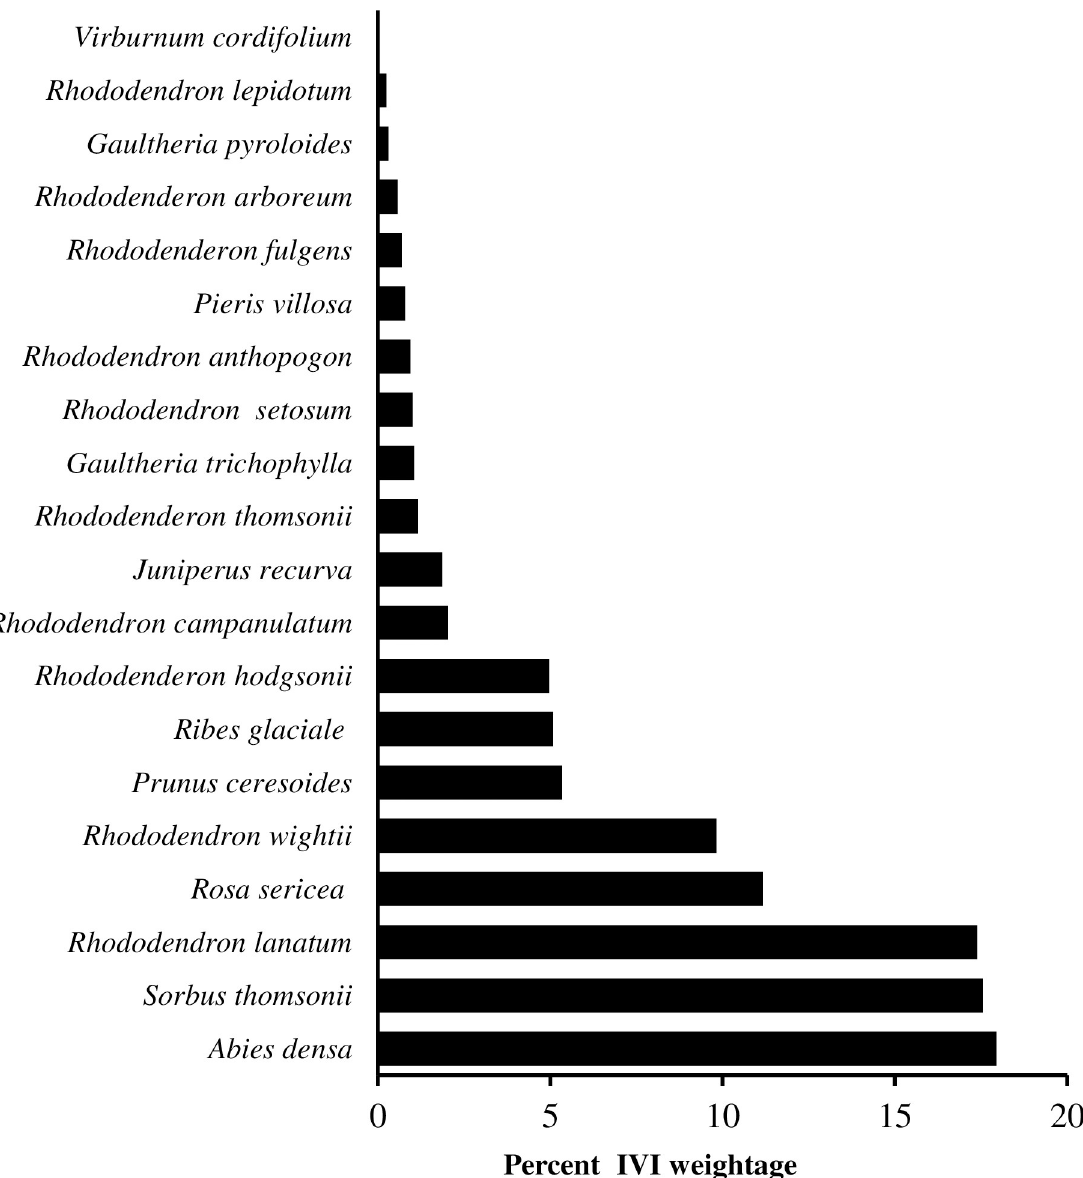
Fig 2. Weightage of woody taxa in timberline vegetation of Khangchendzonga National Park.